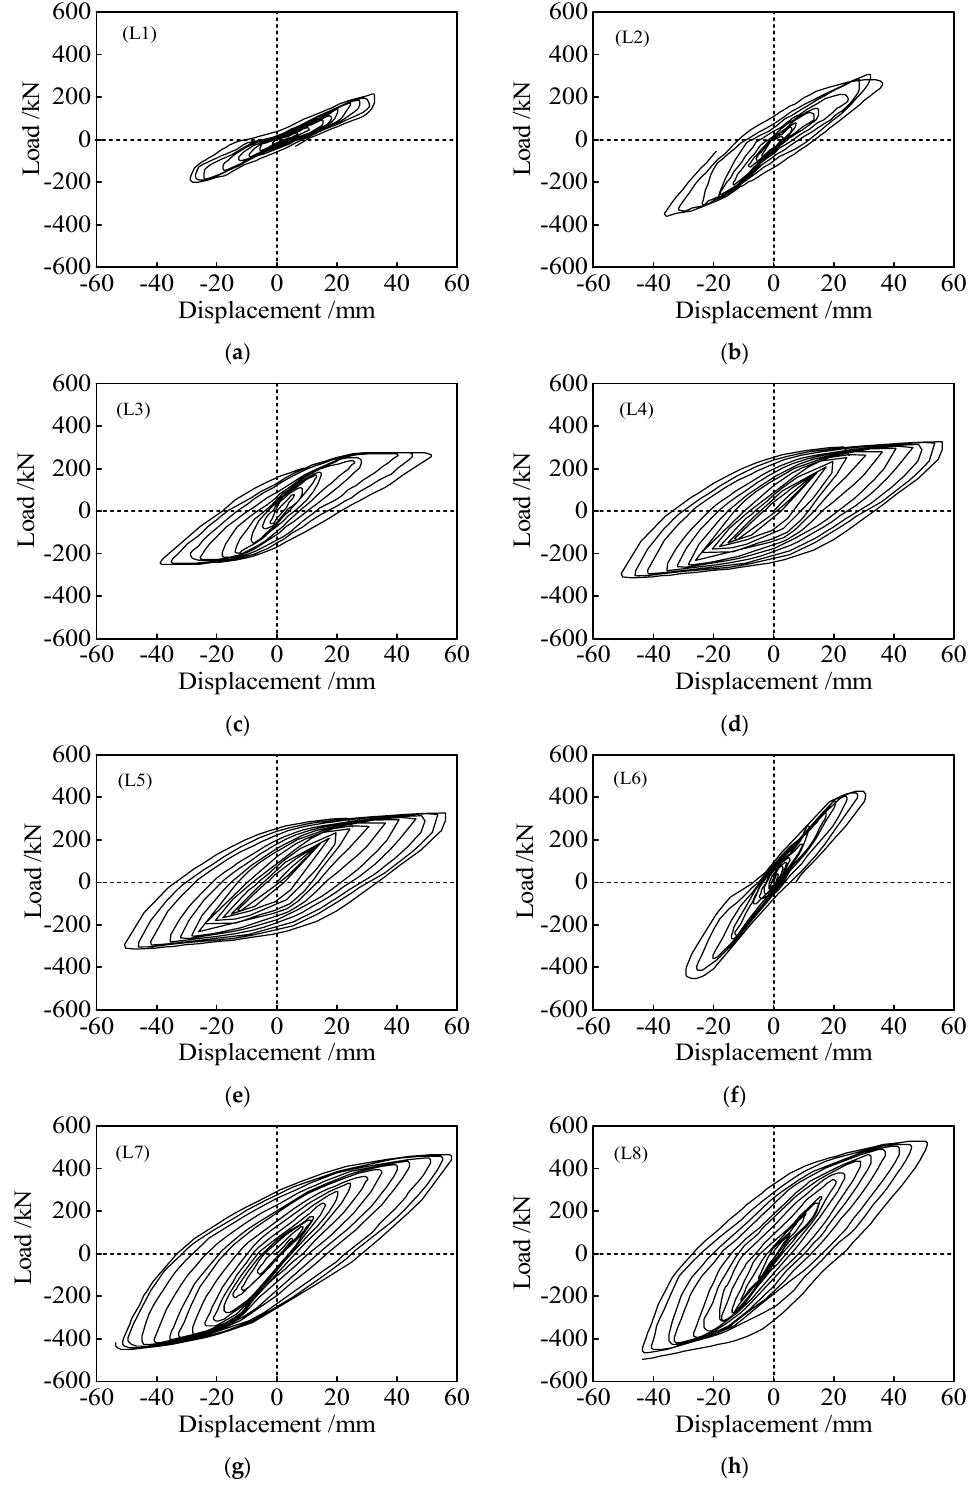
Figure 9. Hysteresis curves of specimens. ( a ) L1; ( b ) L2; ( c ) L3; ( d ) L4; ( e ) L5; ( f ) L6; ( g ) L7; ( h ) L8.